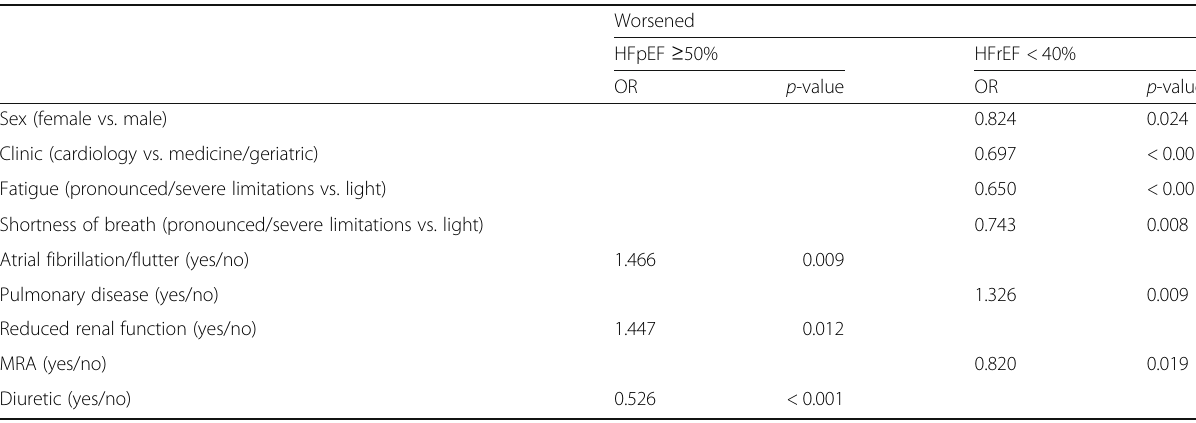
Table 4 Results from multiple logistic regression analysis with Odds Ratios (OR) of factors affecting worsened outcomes in the two groups HFpEF and HFrEF